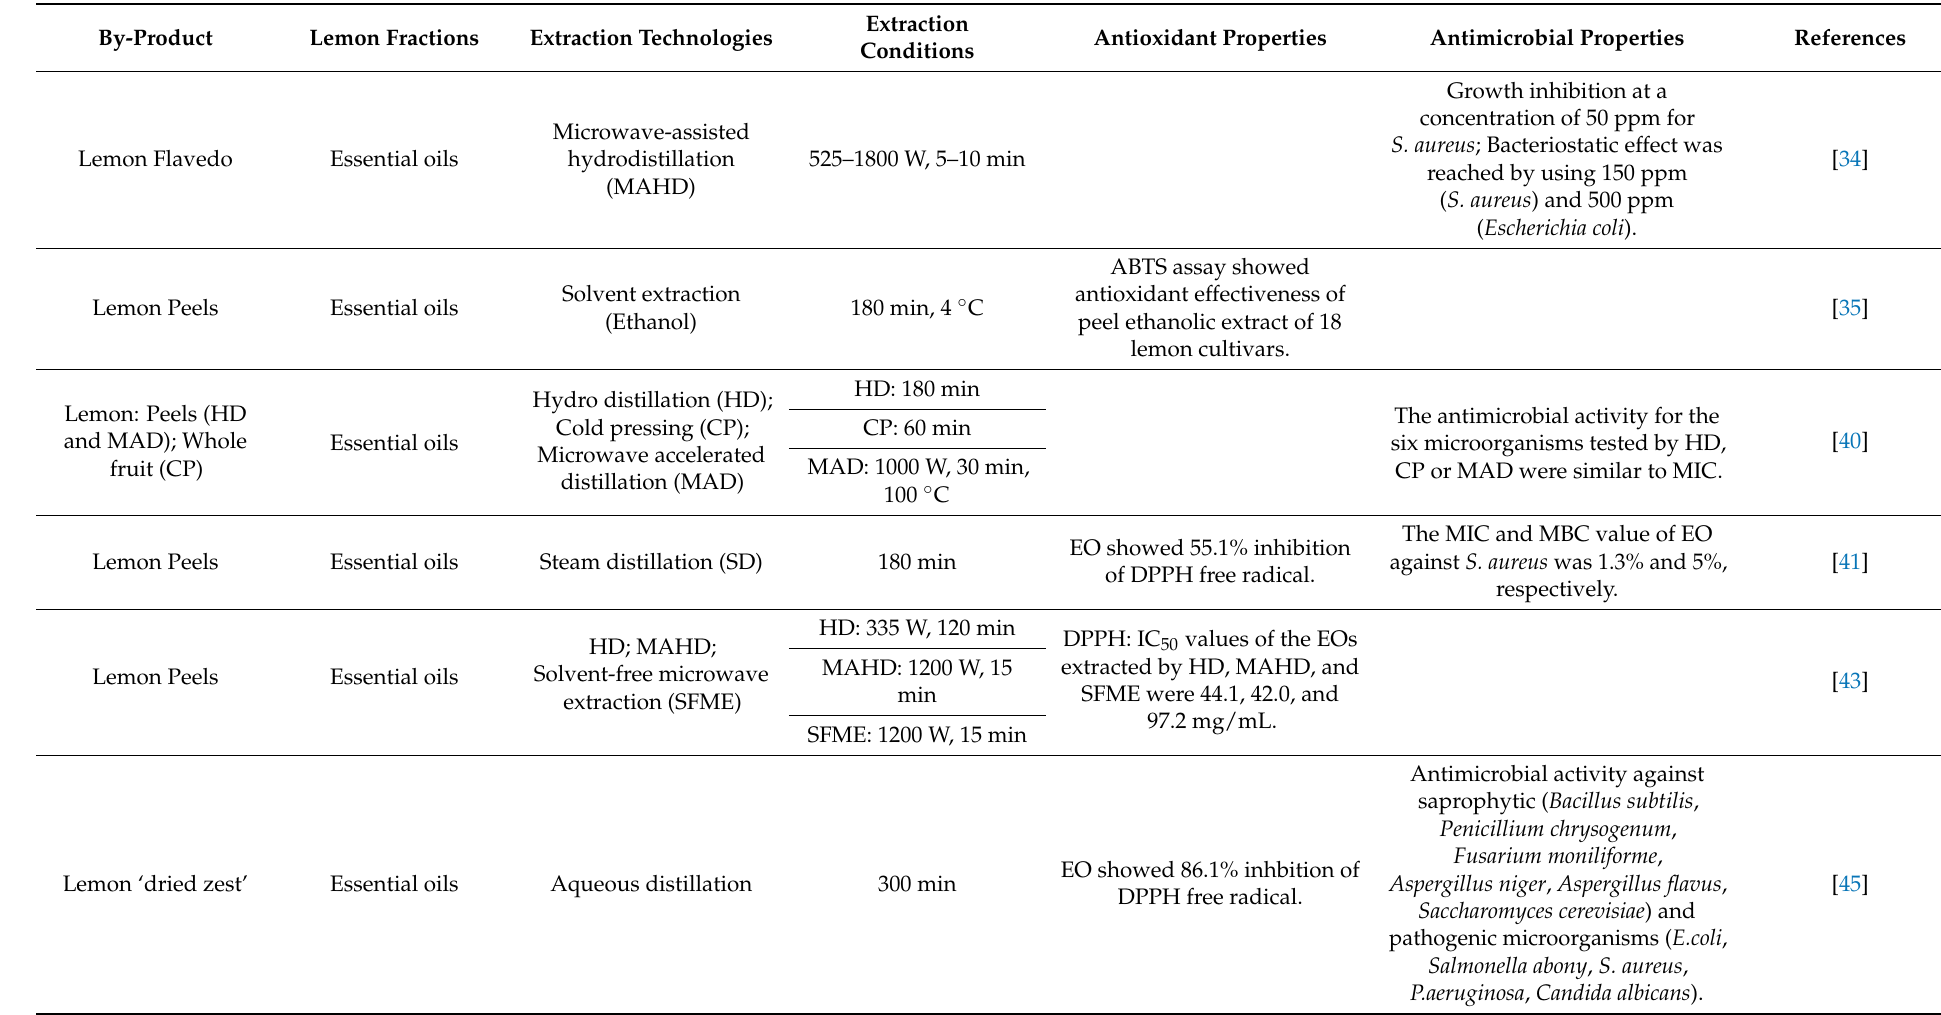
Table 2. Extraction technologies and bioactive properties of essential oils from lemon